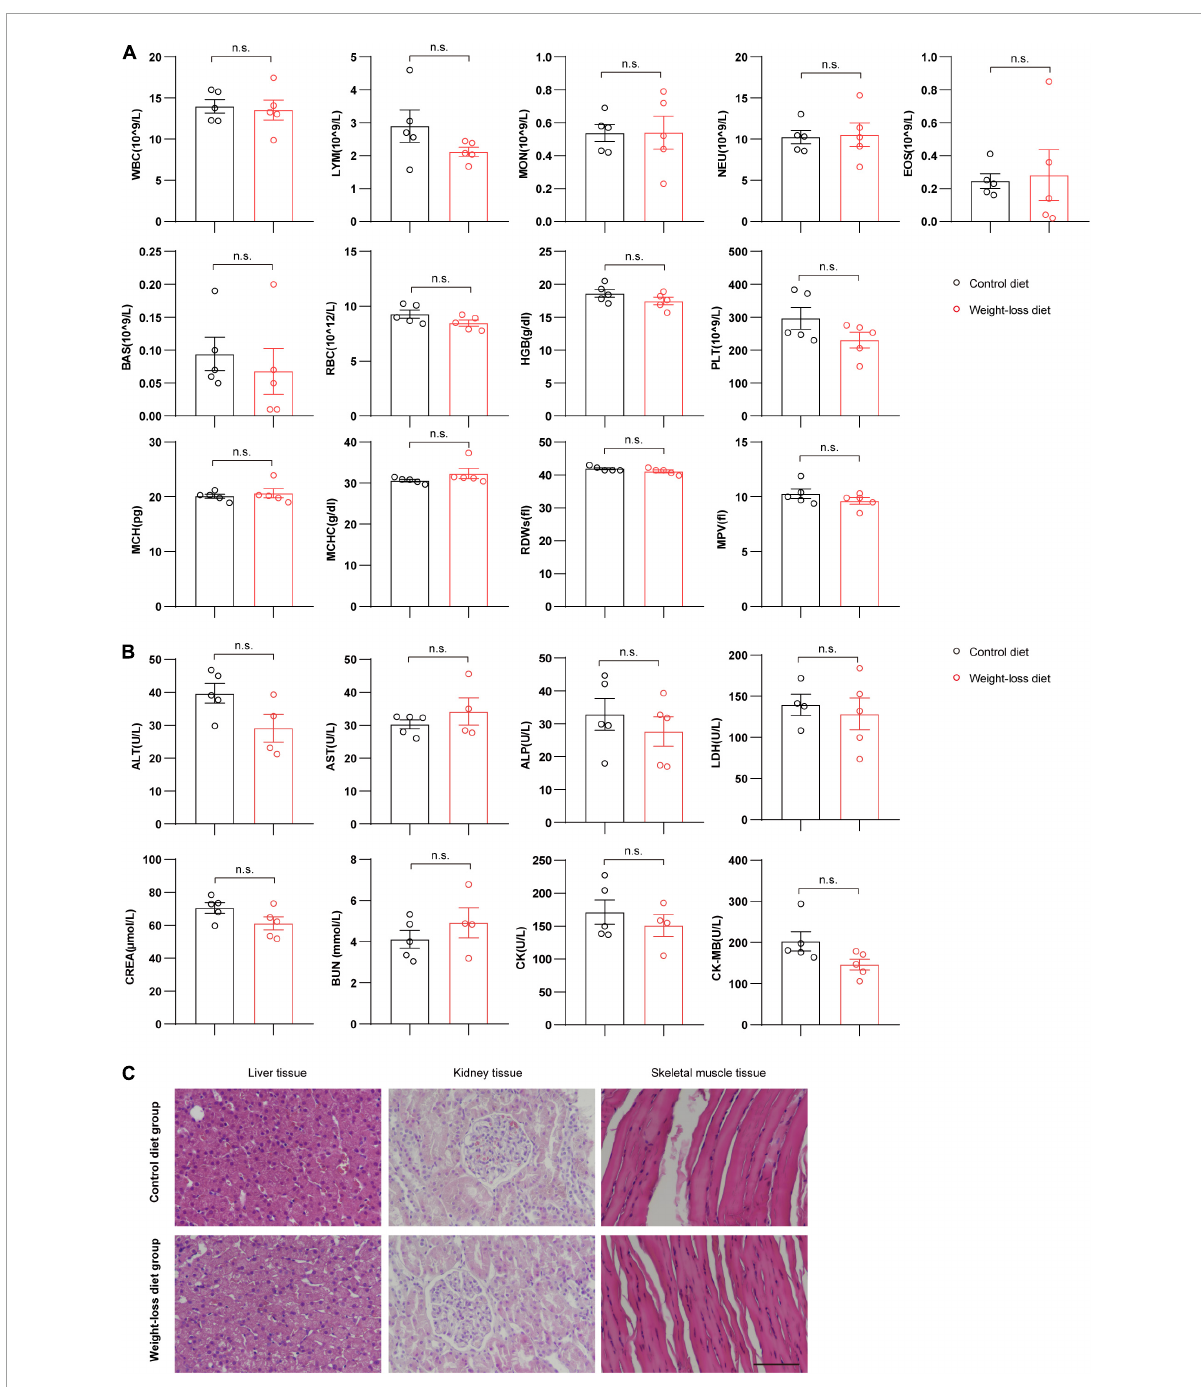
FIGURE7 Evaluation of the adverse effects in beagles fed a weight-loss diet. (A) Whole blood parameter analysis of beagles fed a weight-loss diet and a control diet. n = 5 beagles/group. (B) Blood plasma biochemical evaluation of beagles in the indicated groups. n = 4 ∼ 5 beagles/group. (C) H&E staining evaluation of the morphological changes in liver tissues, kidney tissues and skeletal muscle tissues in beagles fed the indicated diet for 8 weeks. n = 5 beagles/group. Scale bar, 100 µ m. The data of RDWs in panel (A) are presented as the means ± SEMs and analyzed by the Mann–Whitney U non-parametric test and the other data in panels (A,B) are presented as the means ± SEMs and analyzed by Student’s two-tailed t -test. n.s., not significant; WBC, white blood cell; LYM, lymphocytes; MON, monocytes; NEU, neutrophils; EOS, eosinophils; BAS, basophils; RBC, red blood cell; HGB, hemoglobin; PLT, platelets; MCH, mean corpuscular hemoglobin; RDW, red cell distribution width; MPV, mean platelet volume; MCHC, mean corpuscular hemoglobin concentration; ALT, alanine aminotransferase; AST, aspartate aminotransferase; ALP, alkaline phosphatase; LDH, lactate dehydrogenase; CREA, creatinine; BUN, blood urea nitrogen; CK, creatine kinase; CK-MB, creatine kinase